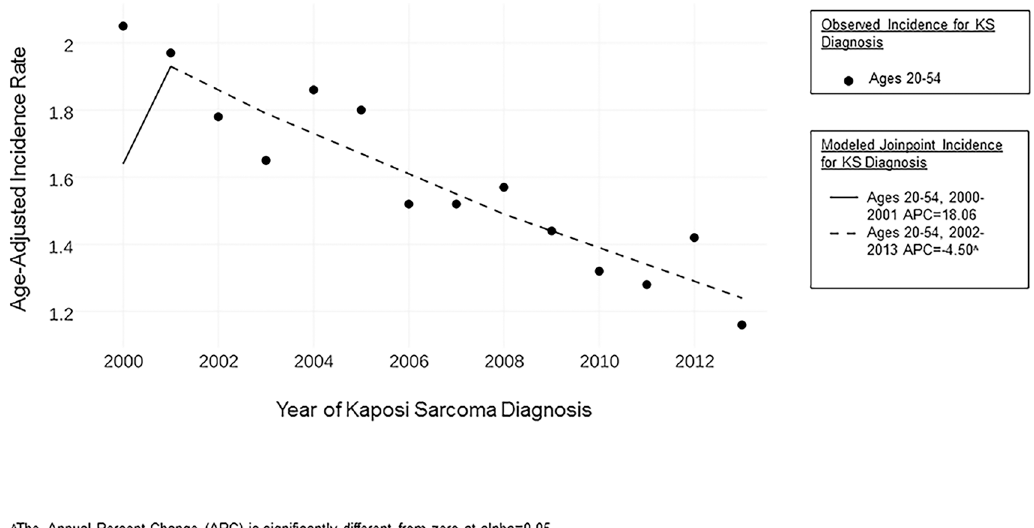
Fig 1. KS incidence in the U.S., 2000–2013,N =